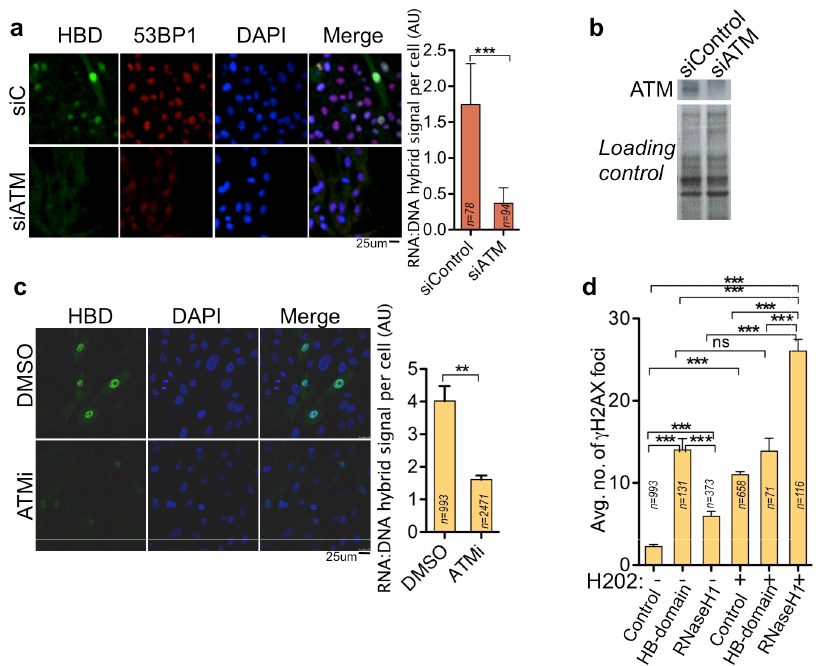
Figure 7. RNA:DNA hybrid formation is central to ATM-53BP1 repair pathway. ( a ) Immunofluorescence using the anti-flag to quantify nuclear hybrid-binding (HB) domain foci signal in pre-permeabilized RPE cells and quantification of HB domain signal in cells treated with siATM, ( b ) Western blot showing ATM depletion. ( c ) Immunofluorescence and HB-domain foci quantification in cells treated with ATM inhibitor. ( d ) Quantitation of γ H2AX foci in cells expressing HB domain or active RNAseH1, in presence or absence of H oxidative stress. siC, non-targeted control siLuciferease RNA. Column bars represent the mean of n number of cells (described on each column) from three independent experiments. Error bars represent SEM. *P ≤ 0.05; **P < 0.01, ***P < 0.001 using Mann-Whitney test ( a , c ) and Kruskal-Wallis test followed by Dunn’s post hoc test ( d